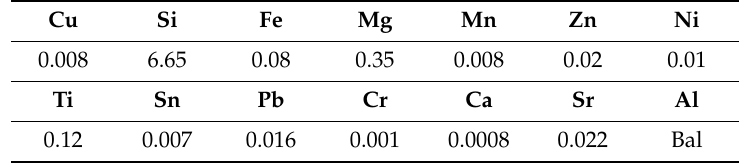
Table 2. Chemical composition of A356 ally (wt %).